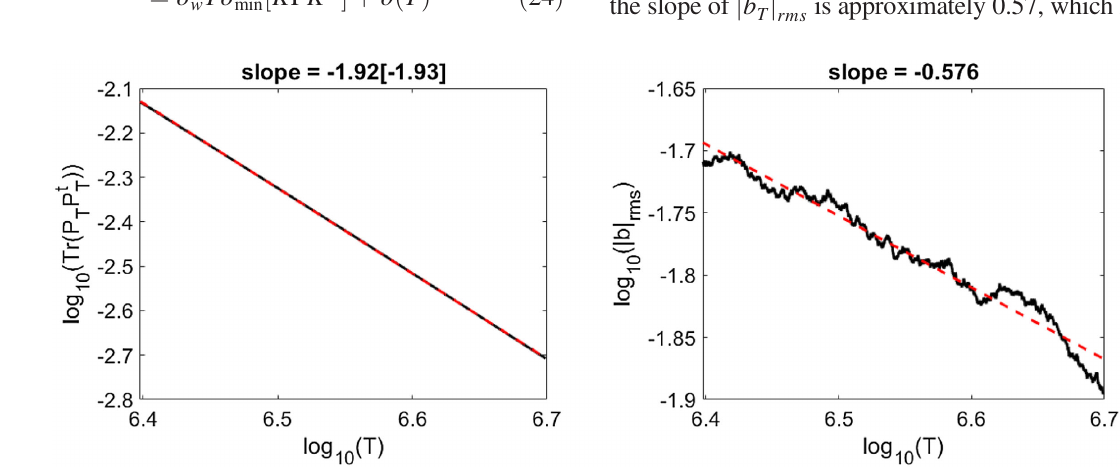
FIG. 10. Left: plotting the logarithm Trace ð P ⊤ T P T Þ versus the log of the number of iterations for σ w ¼ 0 . 1 mm shows that the slope is close to -2. Right: in the same way plotting the log of j b T j rms shows a slope of approximately κ ¼ − 0 . 57 . The red dashes denote the fitted straight